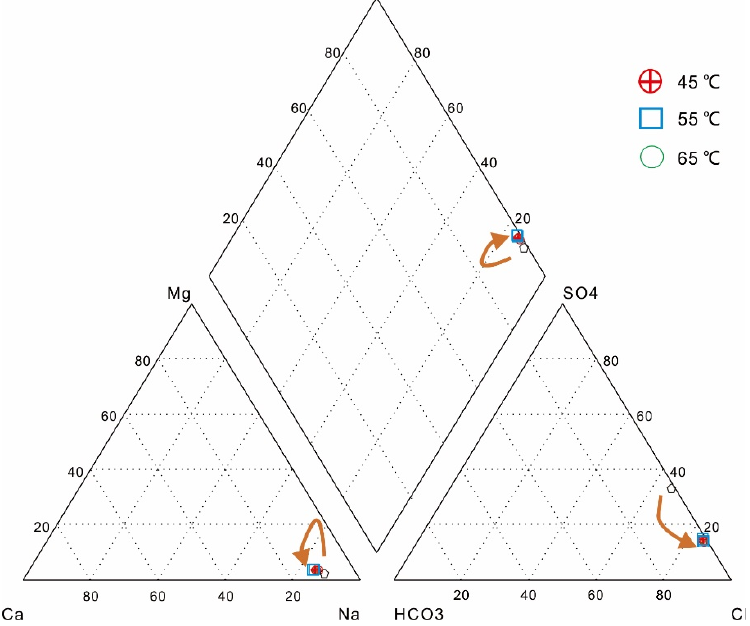
Figure 7. Piper diagram of water samples in the displacement experiment. Orange arrows represent the move trend of major ions.